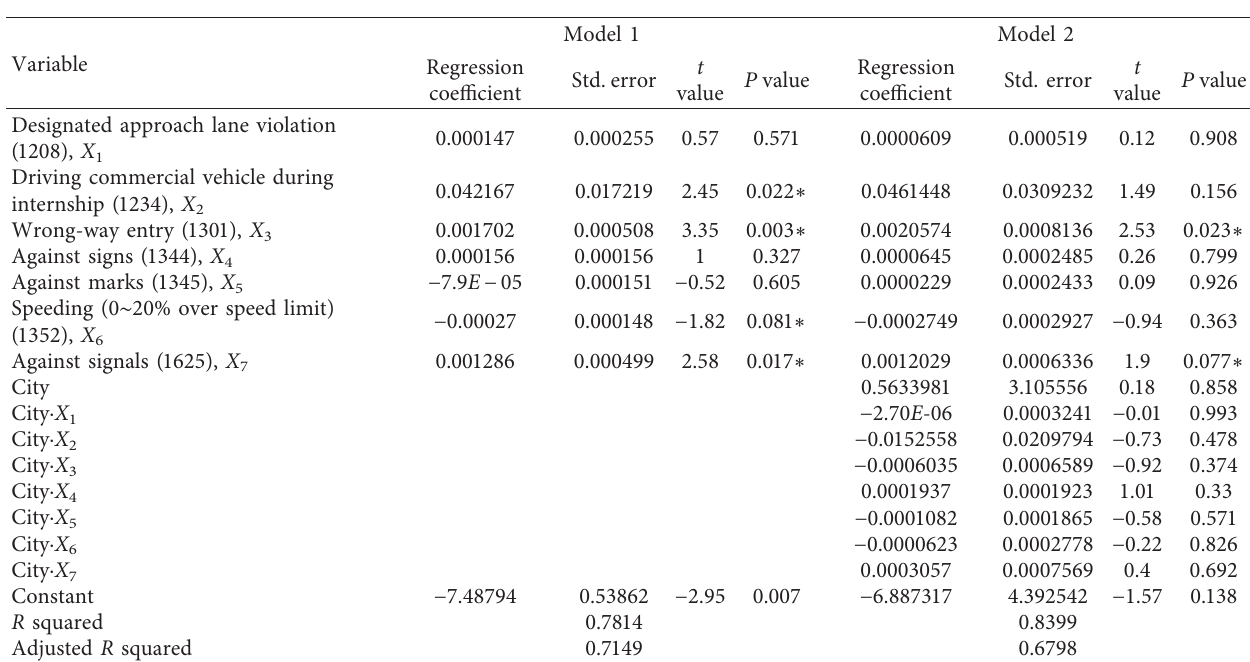
Table 3: The result of White’s test.